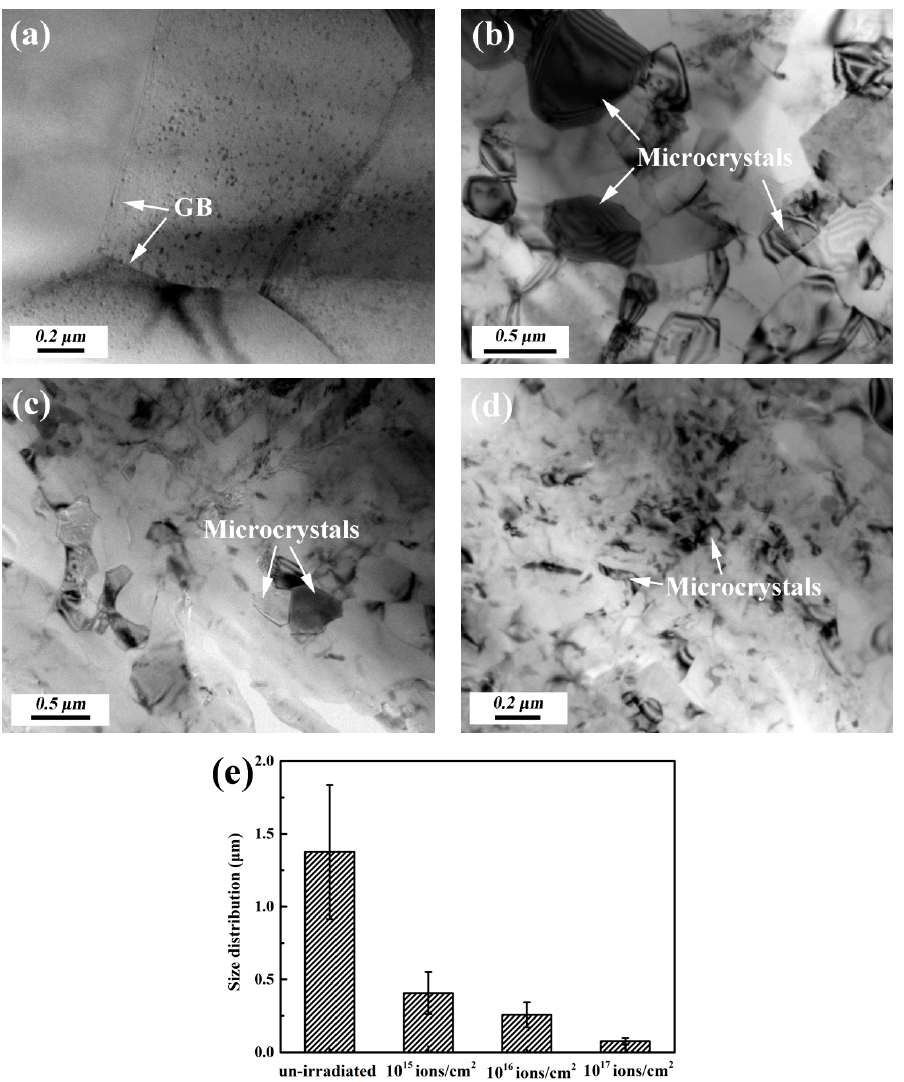
Figure 1. Bright field TEM images of samples without and with irradiation: ( a ) un-irradiated sample; ( b ) 10 15 ions·cm − 2 ; ( c ) 10 16 ions·cm − 2 ; and ( d ) 10 17 ions·cm − 2 . ( e ) grain size distribution of un-irradiated and irradiated samples.